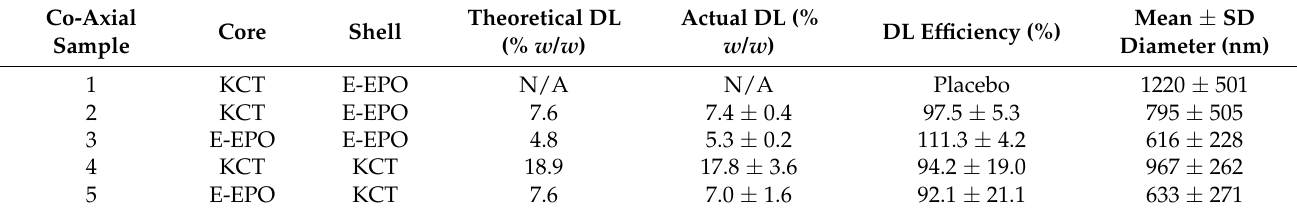
Table 1. The formulations tested had KCT and E-EPO alternating between the core and shell solutions. CPM was always added at 3.5% ( w/v ) in the core apart from system 1, a placebo. The table shows the drug loading efficiency and mean diameter of the nanofibres. DL= drug